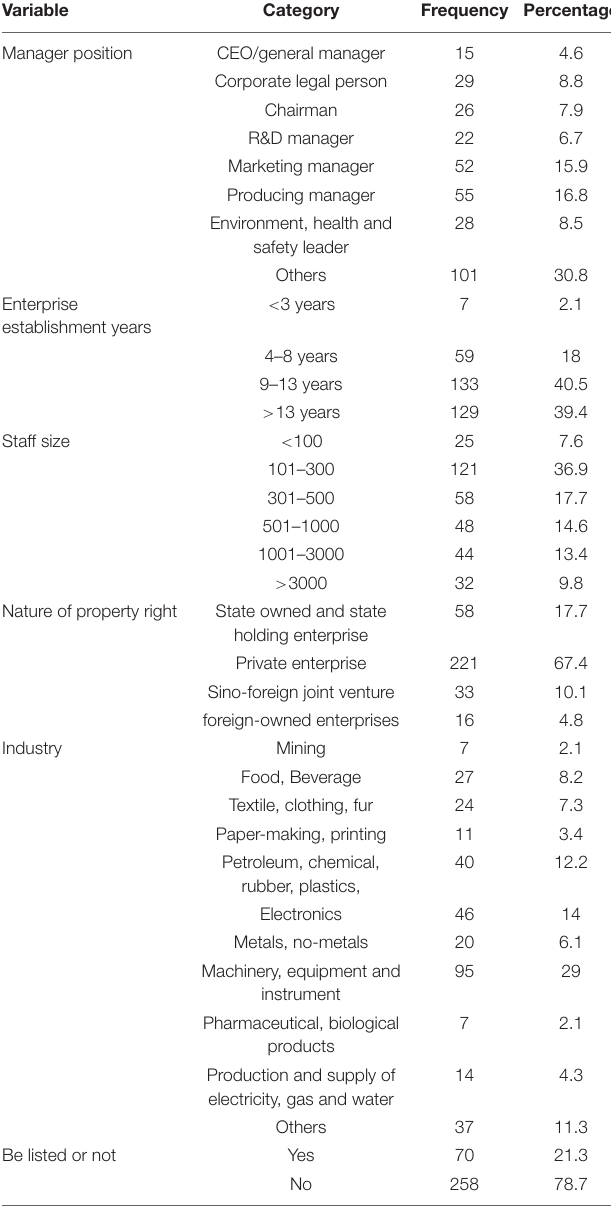
TABLE 1 | Results of descriptive analysis of